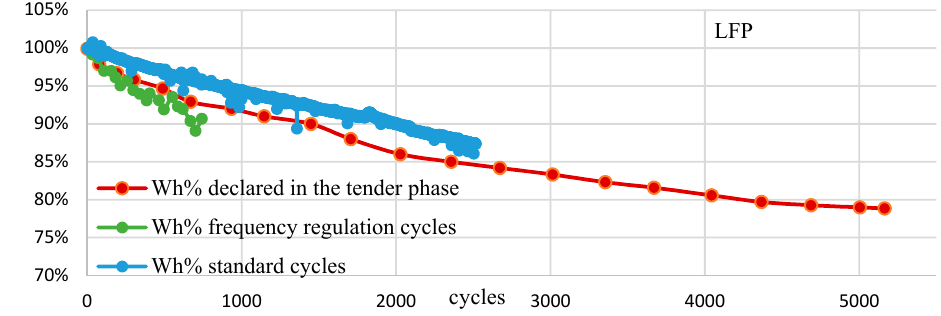
Figure 7. Lithium iron phosphate (LFP) technology: comparison between the expected ageing, declared in the tender phase, and the ageing after the standard and frequency regulation cycles.